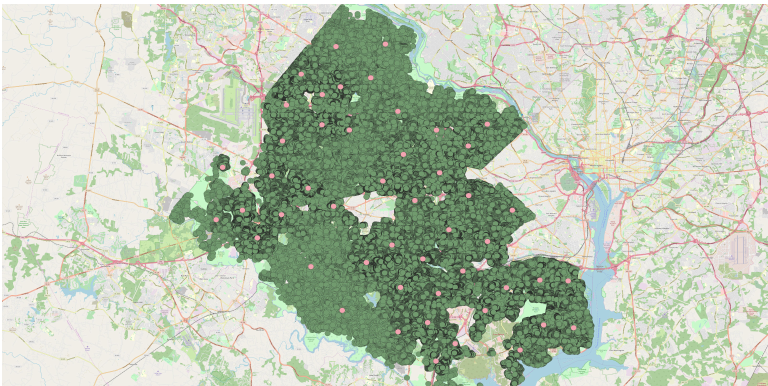
Figure 18. Cluster analysis with the aid of K-means clustering over the generated map with 50 cluster IDs.